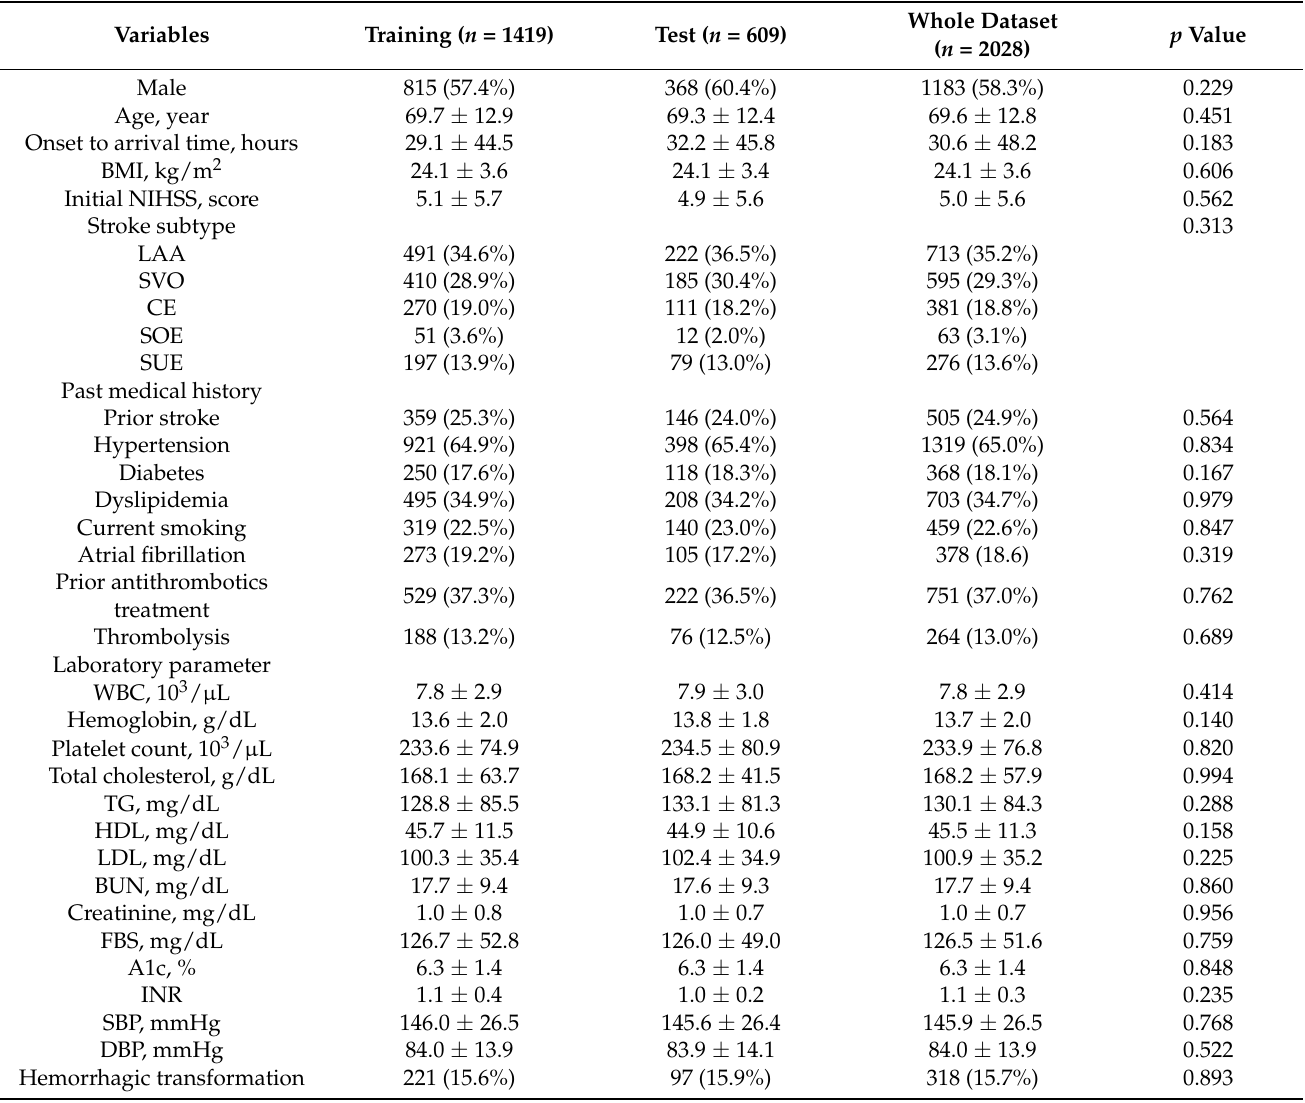
Table 1. Comparison of baseline characteristics between training and test datasets.